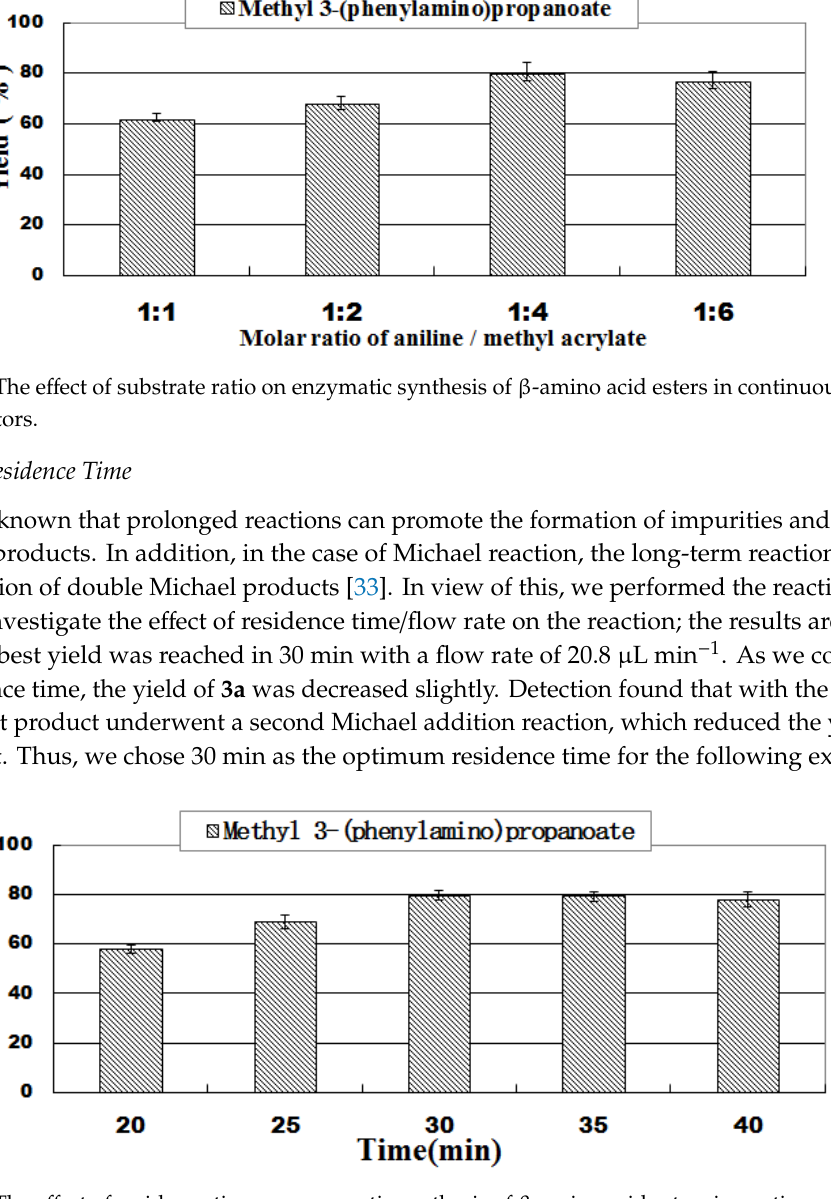
Figure 5. The effect of residence time on enzymatic synthesis of β-amino acid esters in continuous-flow microreactors.